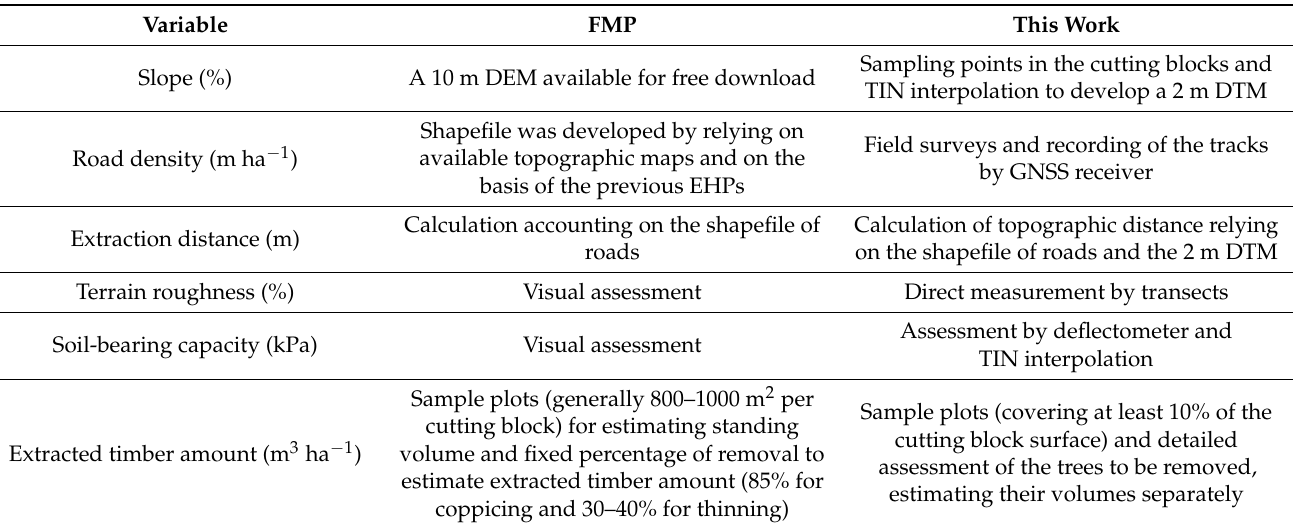
Table 2. Description of the surveys carried out by the local forest engineer for the development of the FMP and by the authors of the present